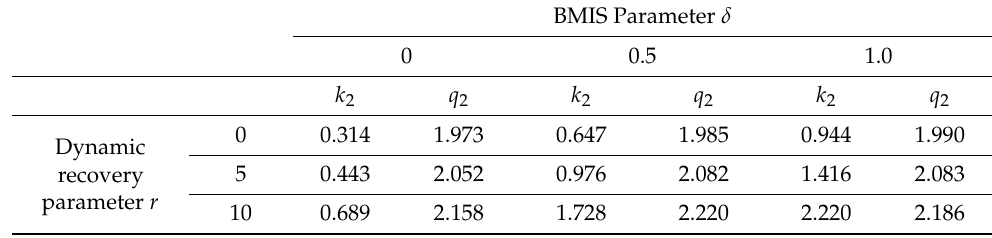
Figure 4. Double logarithmic diagram highlighting the power law dependence of ( ) ( ) H ξ ωξ with respect to ξ for various values of r and δ .